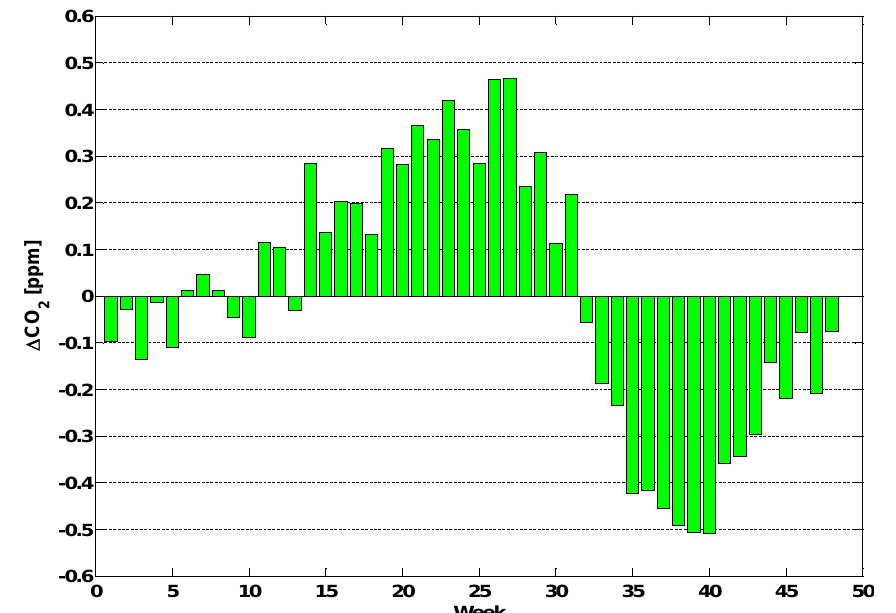
Figure 14. Simulated-minus-observed CO 2 for a set of 312 observation sites by